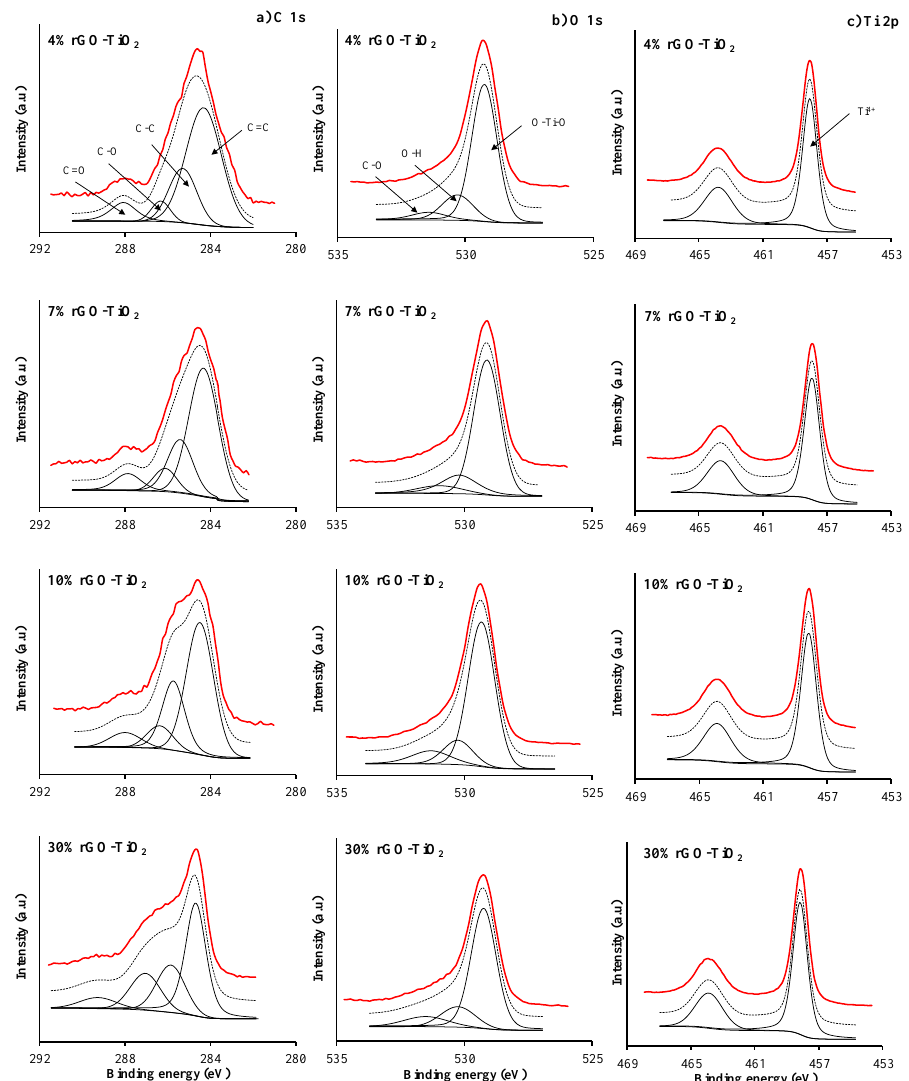
Figure 9. XPS profiles of rGO-TiO 2 composites: ( a ) C 1s spectra; ( b ) O 1s spectra and ( c ) Ti 2p spectra. Continuous red line: experimental profile; discontinuous black line: fitted profile. Table 7. Ti/C, A C-O /A C-C ratios, species percentages, and bond energies (in brackets, eV) obtained by XPS analysis.